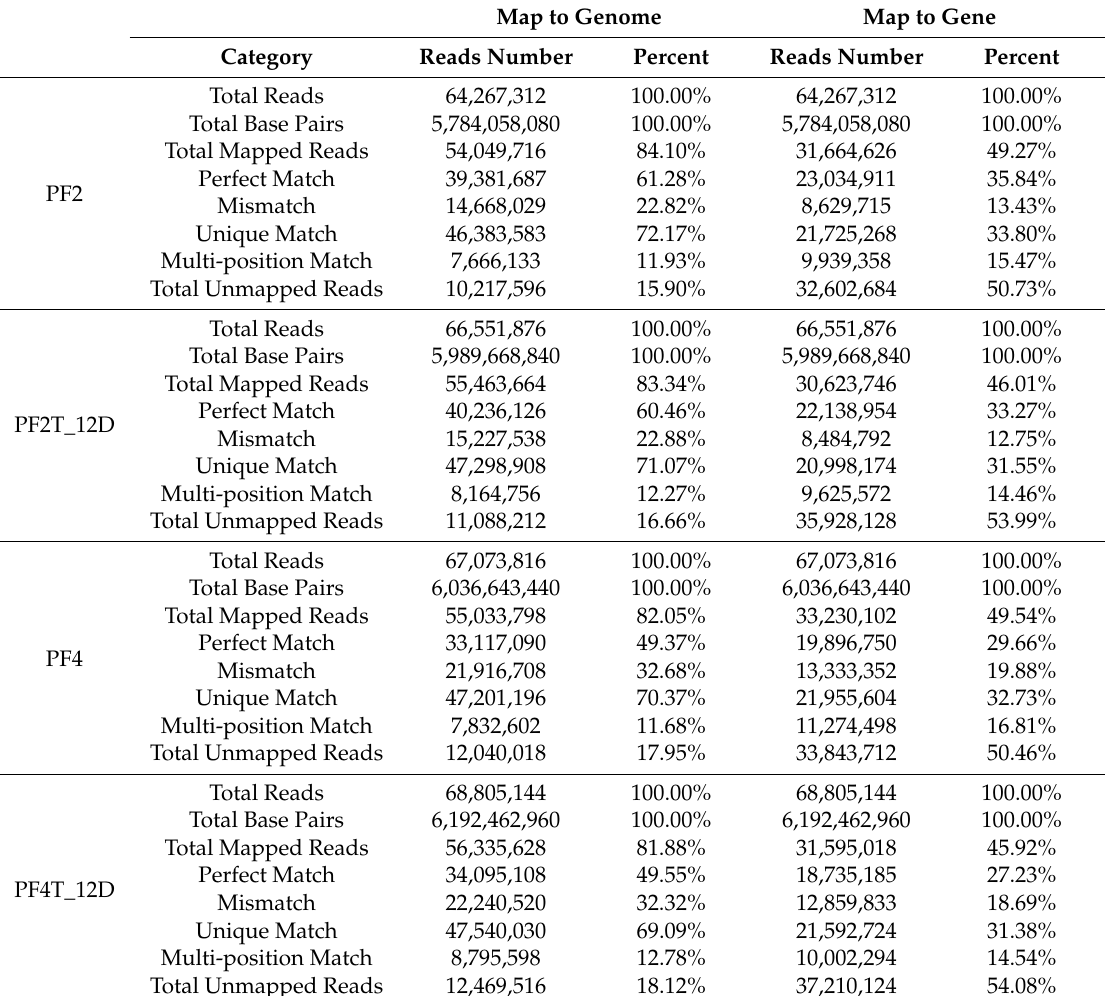
Table 1. The statistics of clean reads mapped to reference gene and